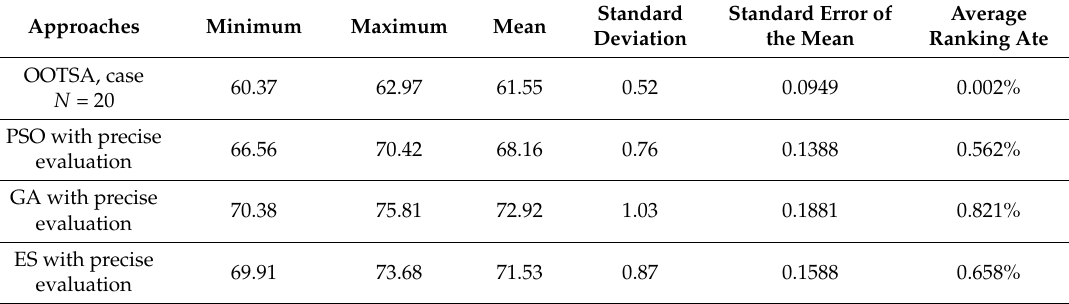
Table 4. Statistics of the objective values and average ranking rate over 30 independent